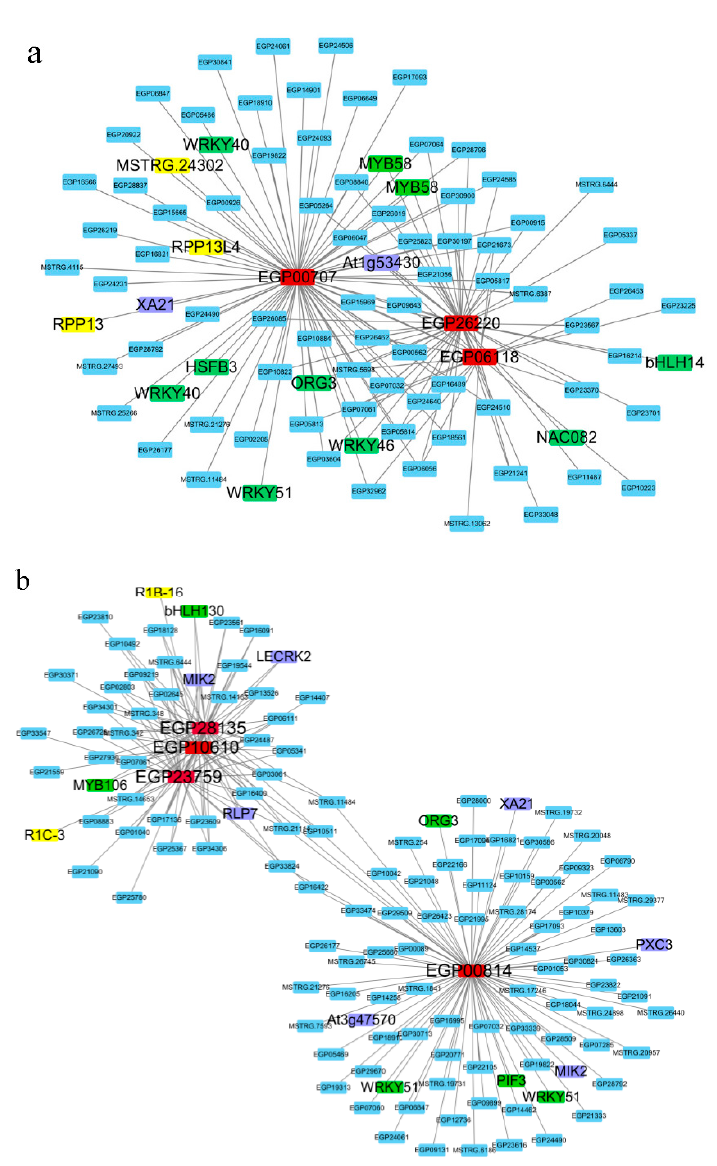
Figure 8. Network regulation of the genes of interest ( a ) Genes interacting with riboflavin pathway-related genes EGP26220 , EGP00707 , and EGP06118. ( b ) Genes interacting with hub genes EGP00814 , EGP23759 , EGP28135 , and EGP10610. Red shows genes of interest, green shows TFs, violet shows disease resistance genes of receptor kinase family, and yellow shows other disease resistance genes.